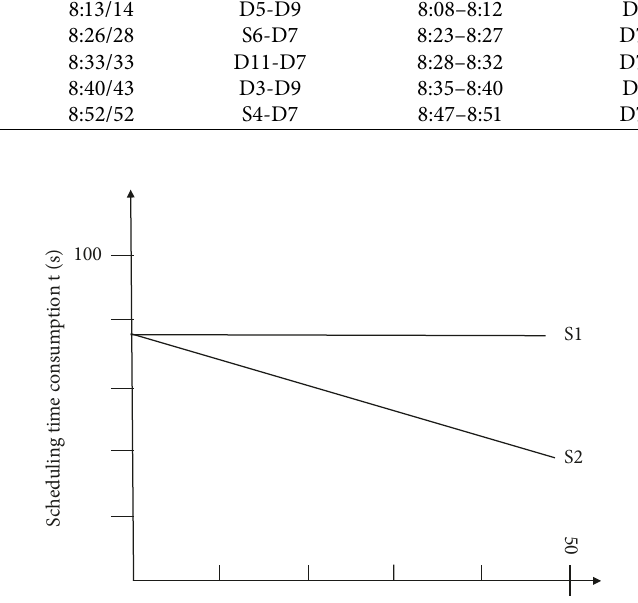
Figure 10: Comparison of shunting intelligences with and without learning